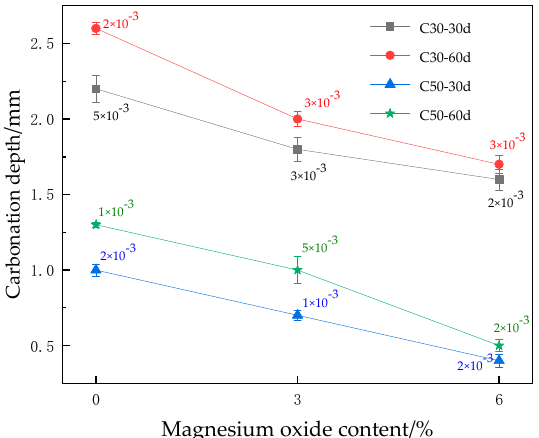
Figure 13. Carbonation depth of concrete.